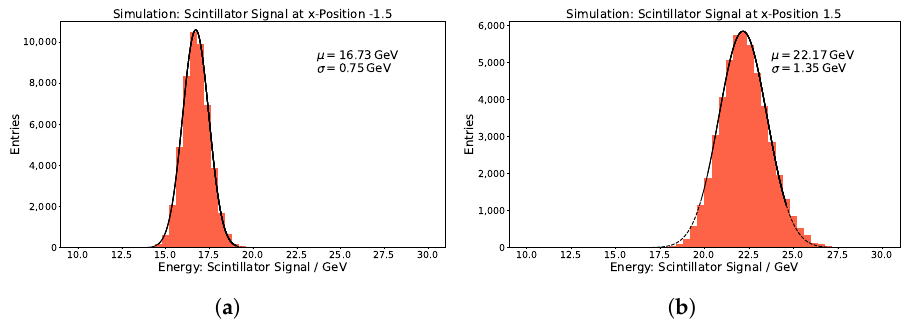
Figure 6. Energy deposit distributions for the scintillation channel when hitting ( a ) a Cherenkov and ( b ) a scintillating fibre (note the identical x scale). The narrower distribution for hitting a Cherenkov fibre is driving the energy resolution improvement in Figure